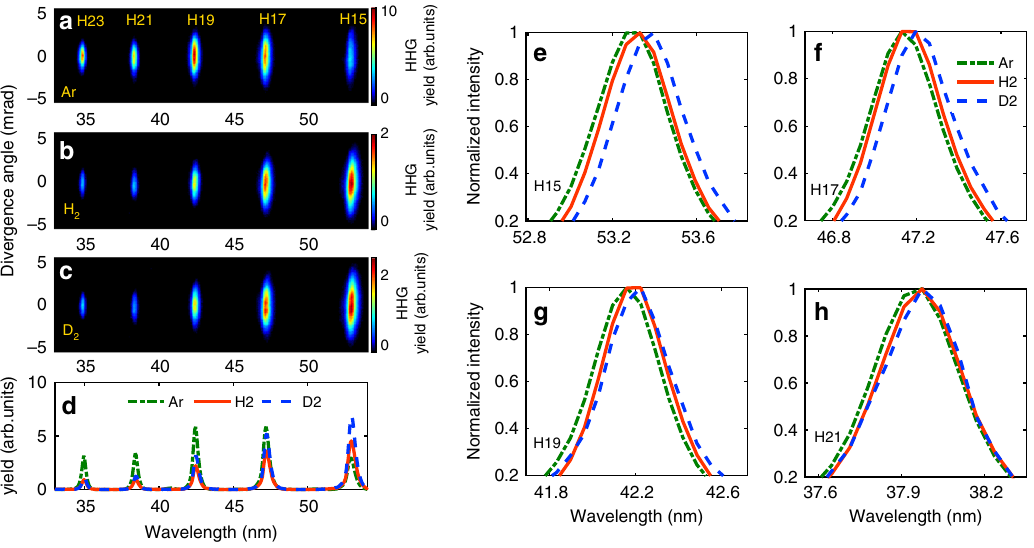
Fig. 2 Experimentally measured harmonic signals. a – c are the spatially resolved harmonic spectra of Ar, H 2 , and D 2 . d shows the spatially integrated HHG signals for the spectra in a (dash-dotted line), b (solid line), and c (dashed line), respectively. For clarity, the dash-dotted line is multiplied by a factor of 0.2. e – h are the normalized harmonic signals of H15-H21 for Ar (dash-dotted line), H 2 (solid line), and D 2 (dashed line), respectively. Here, the laser intensity is 1.5 × 10 14 W cm − 2 and the pulse duration is 30